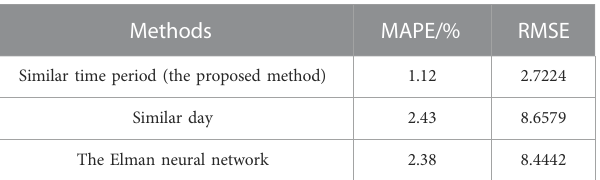
TABLE 6 Prediction errors of the three